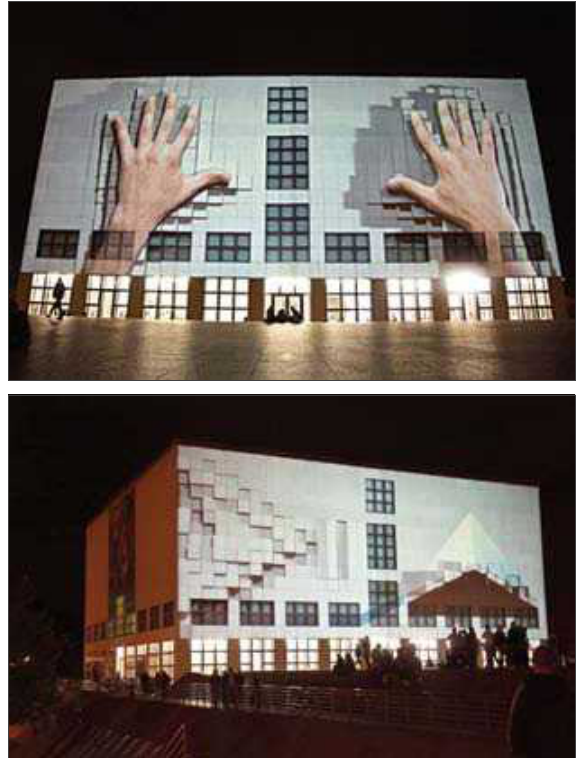
11 pav. D. rossa vaizdo instaliacija 555 Kubik ant hamburgo menų galerijos. archit. O. M. Ungers Fig. 11. D. rossa facade projection 555 kubik on hamburg kunsthalle (art Gallery). arch. O. M. Ungers